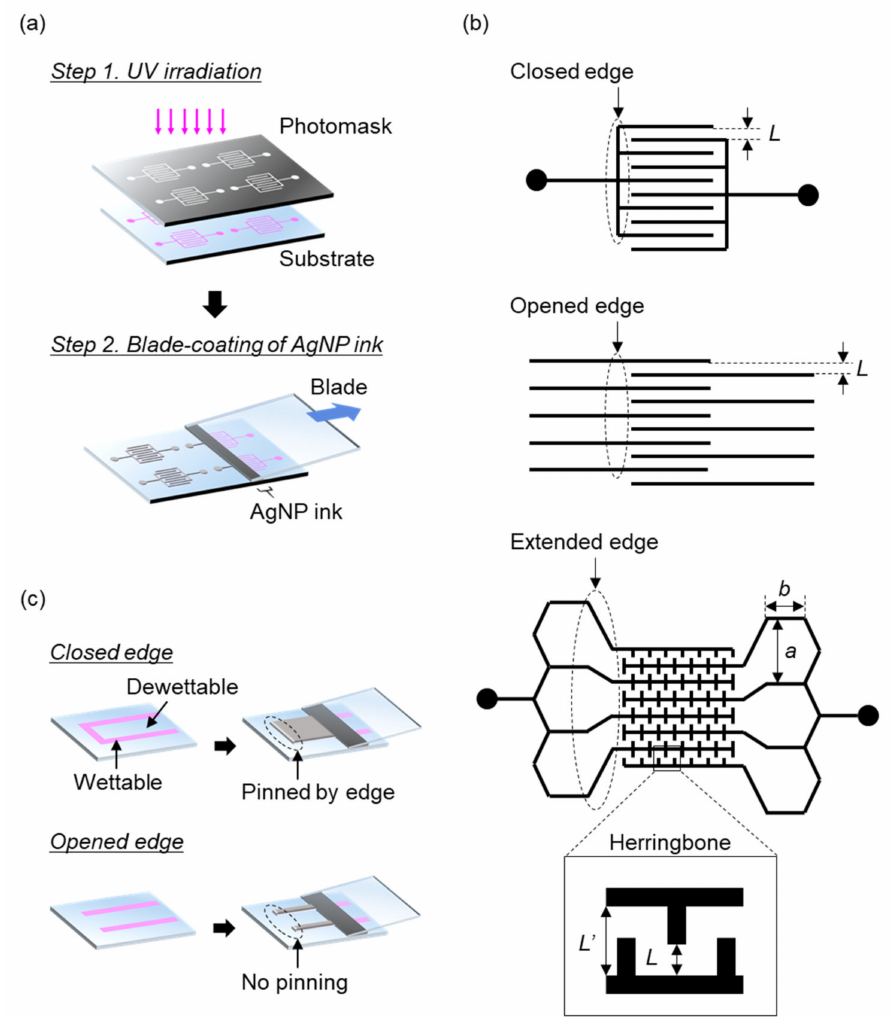
Figure 1. ( a ) Schematic of nanoparticle chemisorption printing. ( b ) Schematic of interdigitated array electrodes with three different designs: closed edge, opened edge, and extended edge. ( c ) Schematic of ink pinning at the edge line perpendicular to the blade-sweep